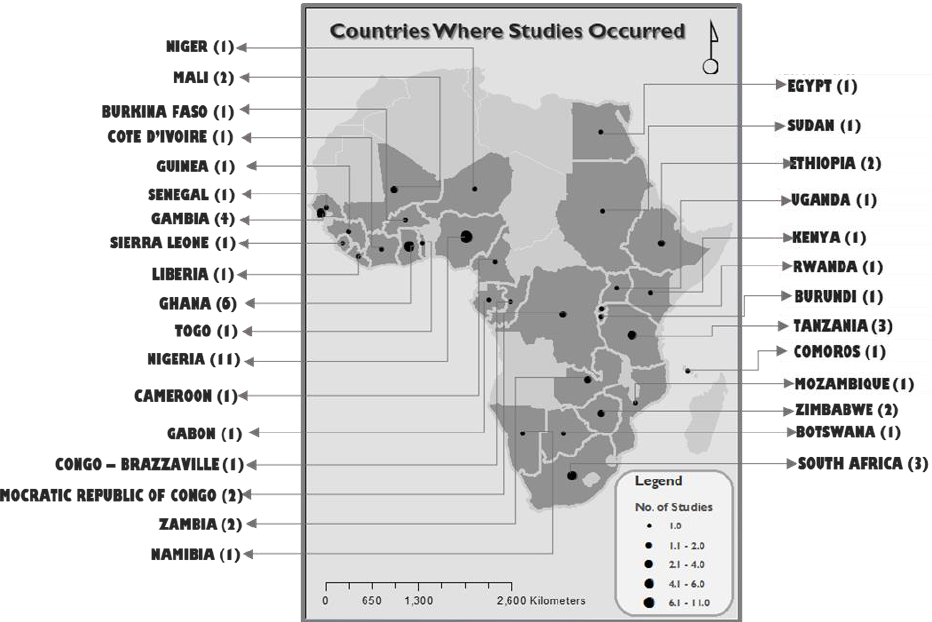
Figure 2. Distribution and number of research articles per country.